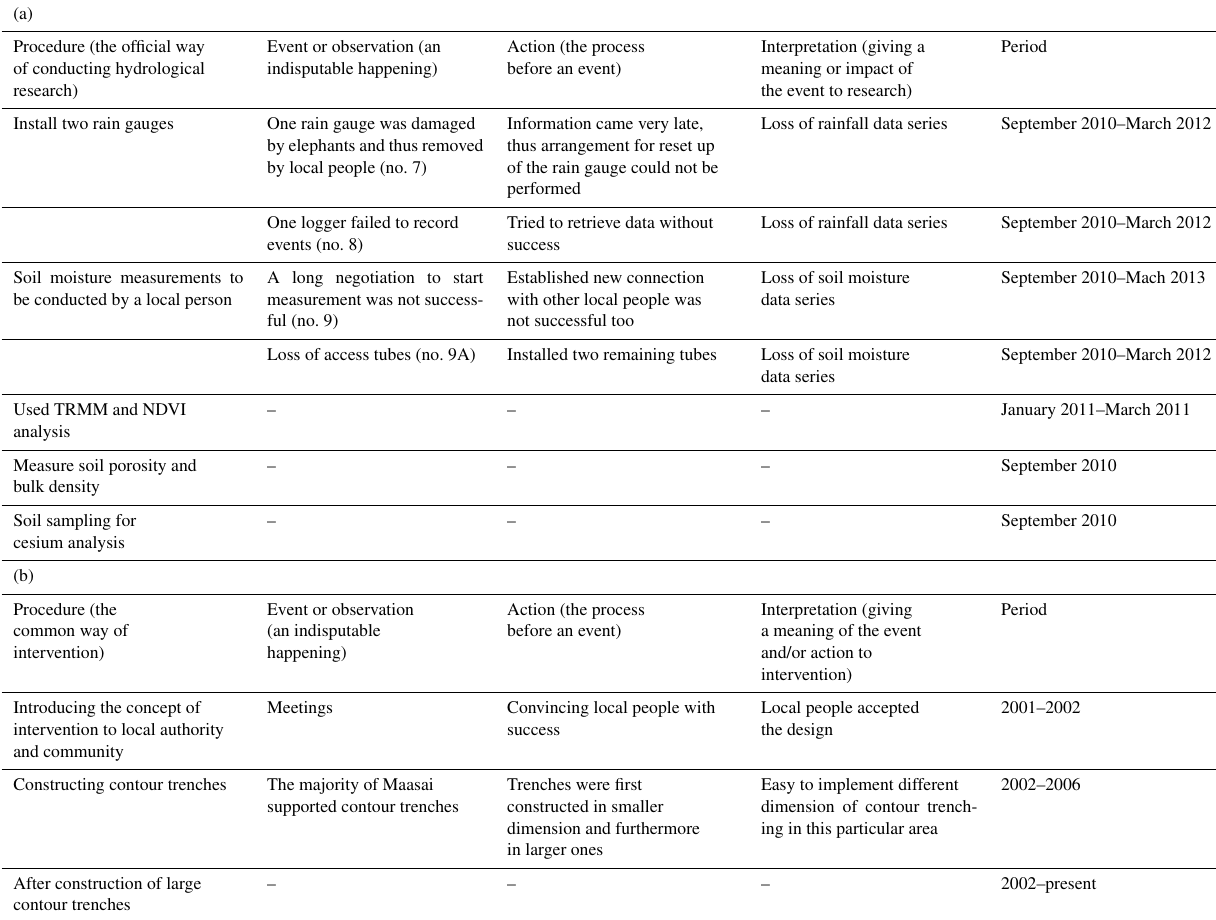
Table 2. (a) Kenya case: hydrological research; (b) Kenya case: intervention.